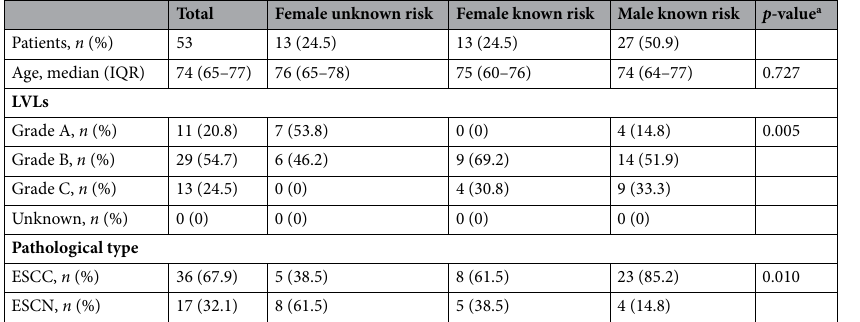
Table 3. Characteristics of patients who underwent NGS analysis in the present study. Values are expressed as median (IQR) or number (%). a Comparisons among the three groups were performed using the χ 2 test or ANOVA. Statistical calculations were performed using JMP 14.3.0 LVLs Lugol-voiding lesions; ESCN esophageal squamous cell neoplasia; ESCC esophageal squamous cell carcinoma; ANOVA analysis of variance; IQR interquartile range.